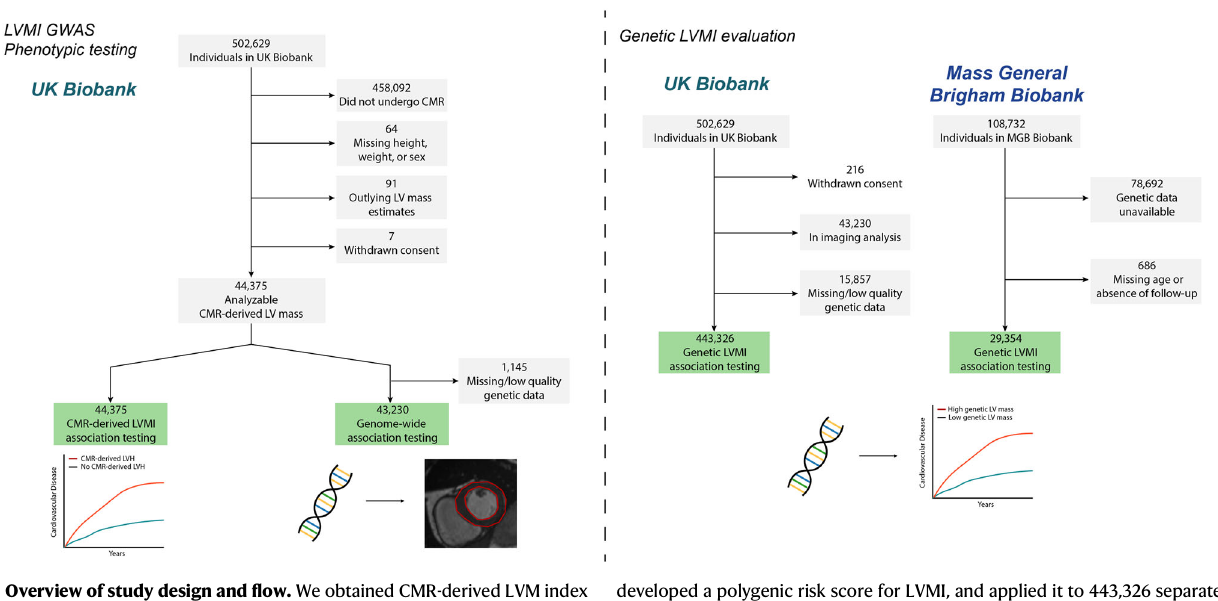
developed a polygenic risk score for LVMI, and applied it to 443,326 separate UK Biobank participants with genetic data (left), and 29,354 individuals from the independent Mass General Brigham Biobank (right), to assess for associations between genetically determined LVMI and cardiovascular